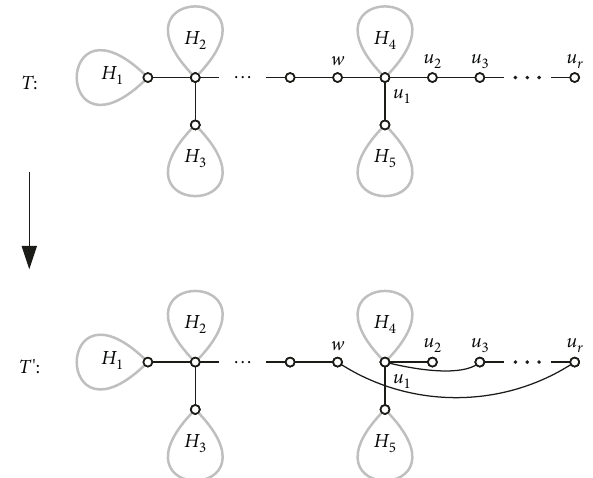
Figure 1: The trees T and T ′ specified in Transformation 1, where the subtree H i may or may not be trivial, i � 1 , 2 , .. . ,